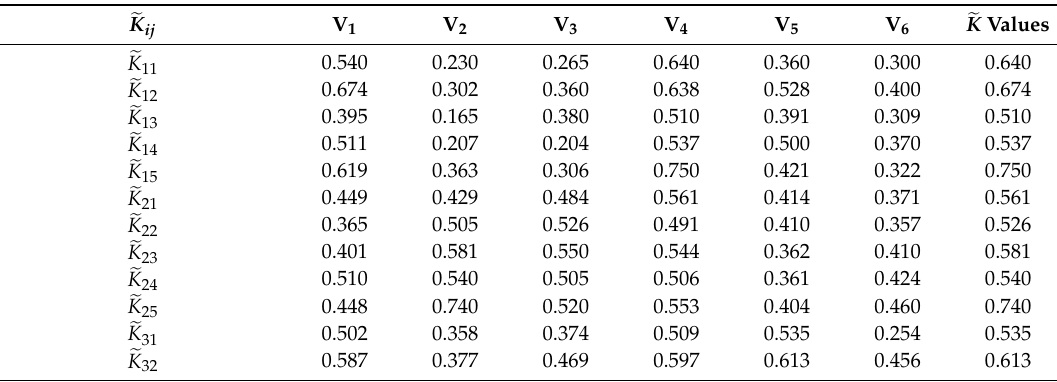
Table 2. Affective-words correlation of digital